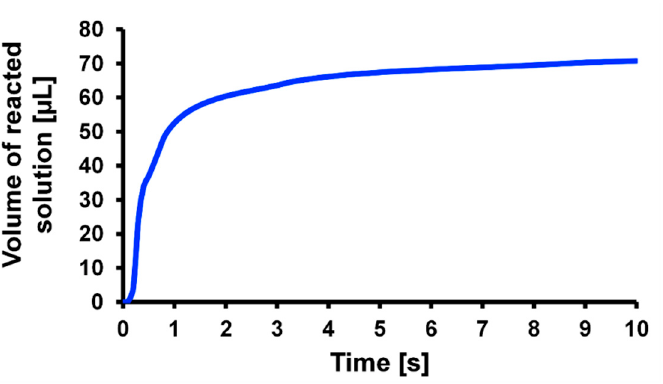
Figure 13. Calculated variation in volume of reacted solution responding to rotation time.